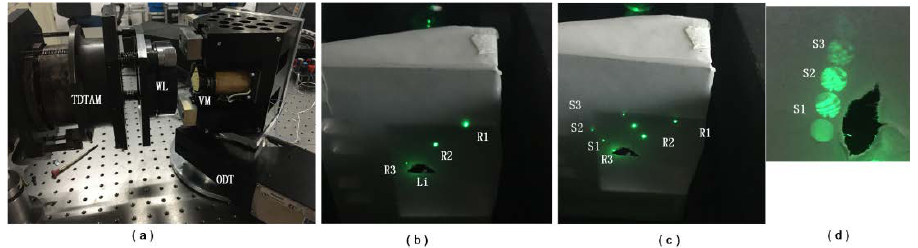
Figure 6. Adjustment process: ( a ) adjustment of WL and VM; ( b ) finding the focus point of the three reflected plane wave vectors R1 and R2 and R3; ( c ) finding the focus of the interference fields S1 and S2 and S3; and ( d ) MFI observed at the out-of-focus position.